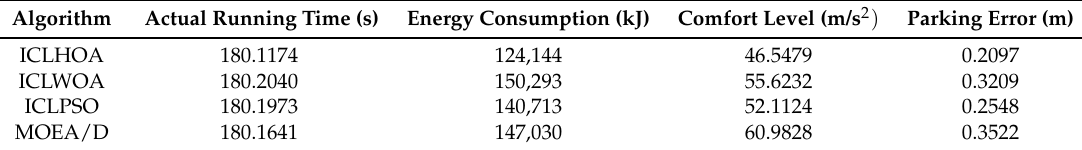
Figure 25. The velocity ideal trajectory profile obtained by improved multi-objective hybrid optimization algorithm using a comprehensive learning strategy (ICLHOA) in each simulation platform. Table 7. The tracking model predictive control (MPC) results of the velocity ideal trajectory profile obtained by partial algorithms under RCL-HILS.